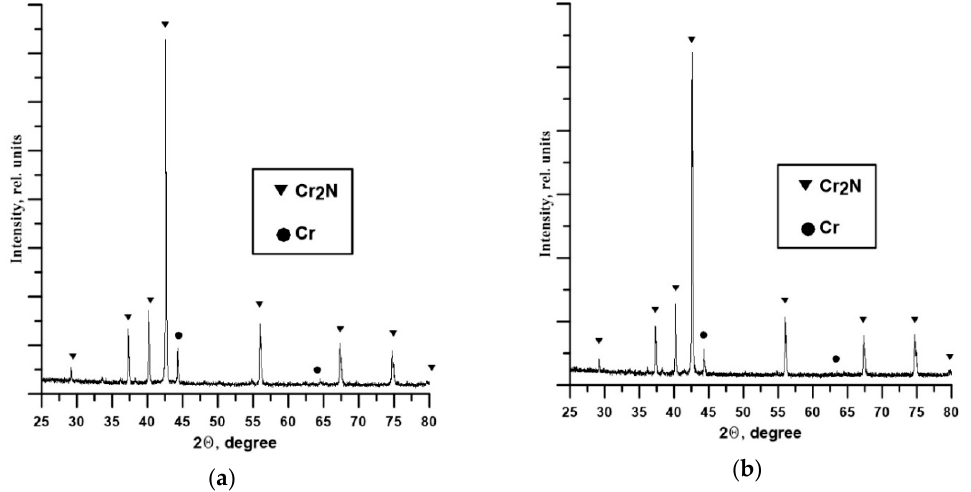
Figure 6. XRD patterns of samples obtained as a result of combustion of chromium in a flow reactor: a—for powder; b—for granules; q = 12 cm 3 /(s·cm 2 ); [Ar] = 12.8%.